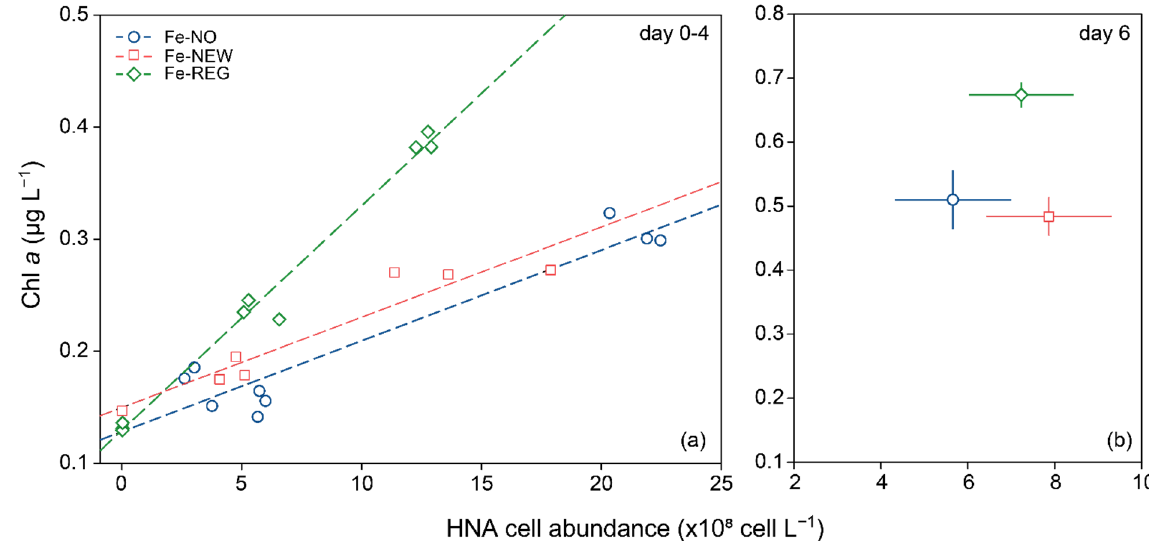
Figure 6. Relationship between Chl a concentration and high nucleic content (HNA) bacterial abundance for the three treatments for day 0–4 ( a ) and day 6 ( b ). The best-fit lines of the linear models are plotted (Fe-NO: slope = 8.1 × 10 − 11 , R = 0.95, p < 0.001; Fe-NEW: slope = 1.2 × 10 − 10 , R = 0.95, p < 0.001; Fe-REG: slope = 2.0 × 10 − 10 , R = 0.99, p < 0.001). ( a ) Dots represent the value for each independent replicate (day 0–4). ( b ) Dots and error bars represent the average and standard deviation of triplicate incubation bottles, respectively.